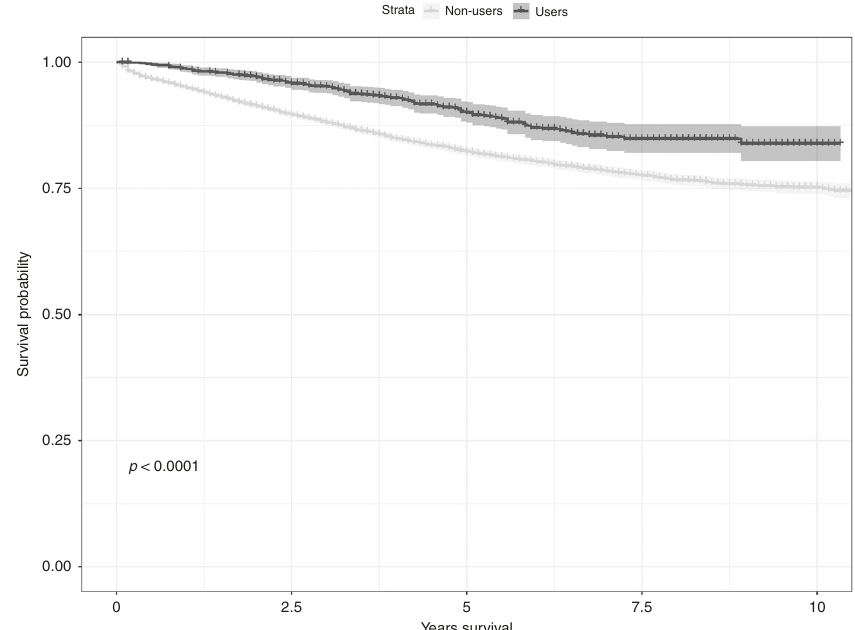
Fig. 2 Cause-speci fi c survival curves strati fi ed by PDE5 inhibitors use. Log-rank test was used to compare the difference of cause-speci fi c survival curves. Shadow part indicates the 95% CI for the survival probability. 1136 patients using PDE5 inhibitors and 11,329 patients without using PDE5 inhibitors were included for survival curve plot,